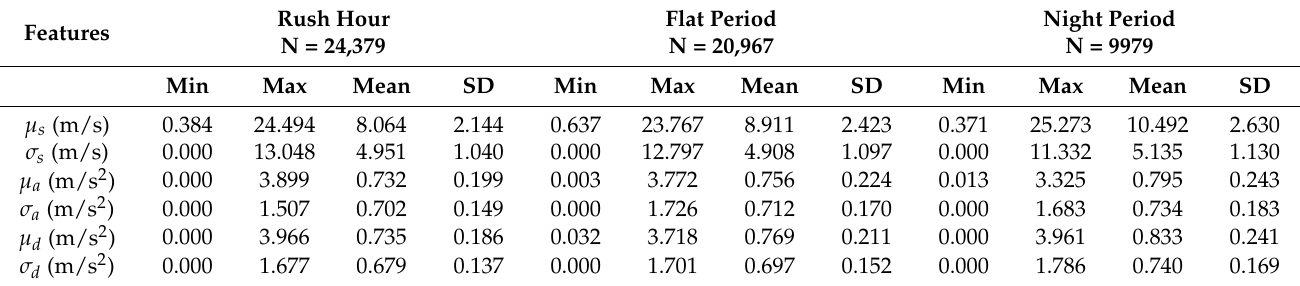
Table 5. Descriptive statistics of driving features at different time periods.